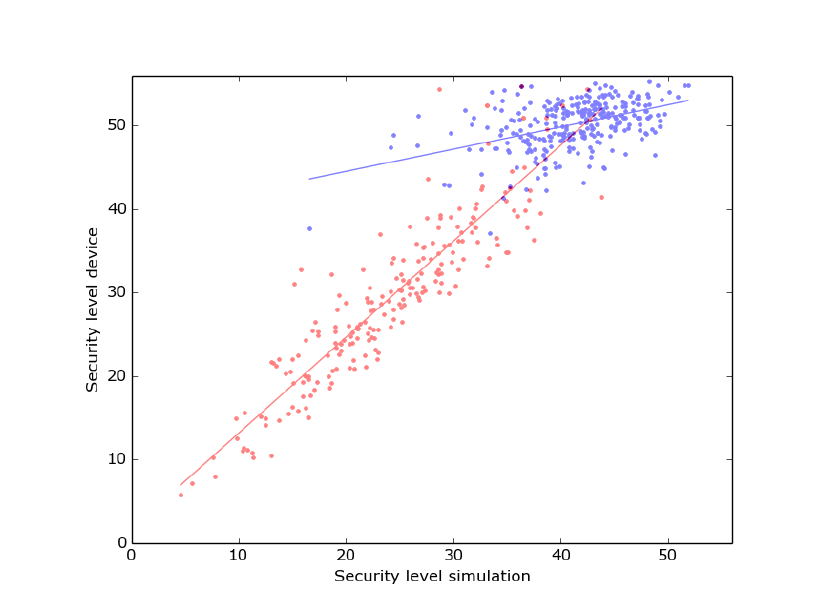
Figure 25: Two groups of random keys, one from a uniform distribution (blue) and one with skewed ratio of zeros and ones (red, either 90% zeros or 90% ones ). Security levels after attacking simulated and measured traces are shown on the x-axis and y-axis, respectively. Linear approximations are plotted for both